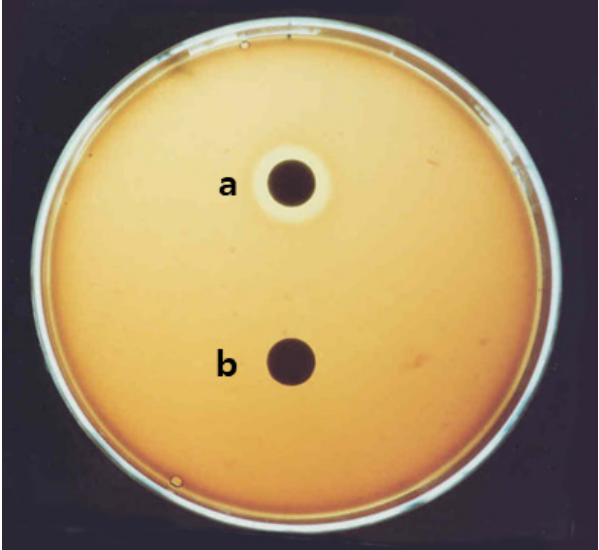
Figure 1. Surfactin production test of Bacillus pumilus HY1. The strain HY1 grown on defibrinogen sheep blood agar at 37 °C for 24 h: ( a ) Bacillus pumilus HY1; and ( b ) Escherichia coli DH5 α . The Esch- sheep blood agar at 37 ◦ C for 24 h: ( a ) Bacillus pumilus HY1; and ( b ) Escherichia coli DH5 α . erichia coli DH5 α were used as negative control of surfactin production in agar plate.